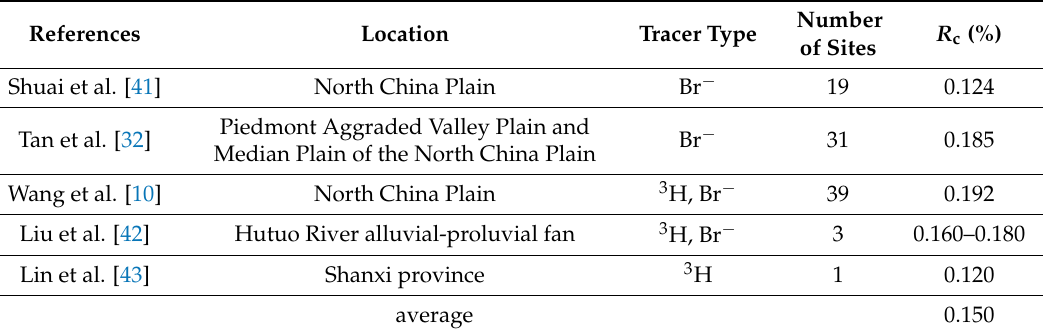
Table 6. Recharge coefficient calculated by injected tracer in other